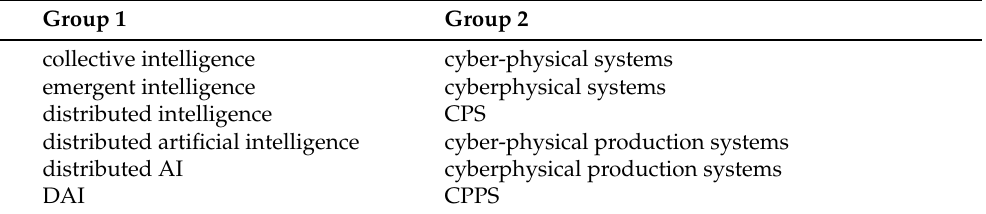
Figure 3. The process used to perform the literature review of collective intelligence in industrial CPS. Table 1. Terms used in the criteria to retrieve the